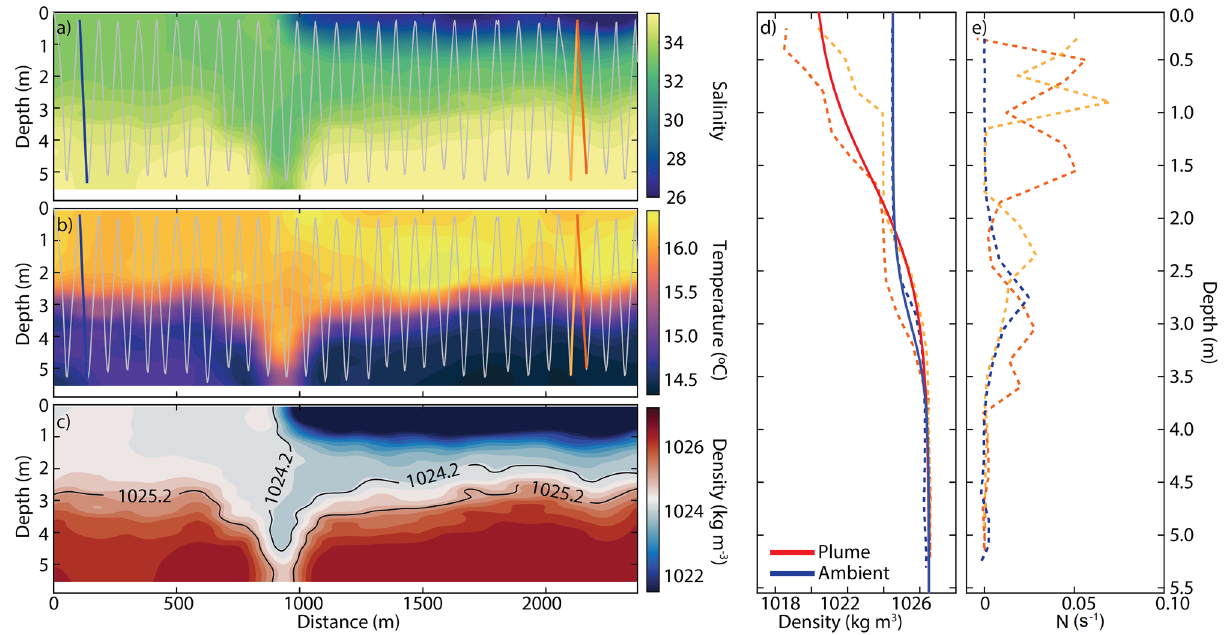
Figure 2. AUV observations and background conditions. AUV cross-front transect of salinity ( a ) and temperature ( b ) with the corresponding yoyo trajectories (grey line). AUV-based density contour map ( c ). Observed (dashed) and idealized (solid) background density ( a ) and Brunt–Väisälä frequency ( N ) profiles on the ambient coastal ocean (blue) and plume (red) side. Dashed dark and light orange lines correspond to upward and downward trajectories, respectively, completed by the AUV in the plume